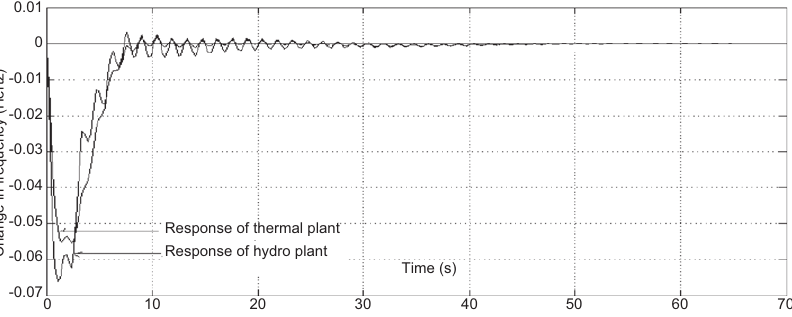
Figure 7. Change in Frequency (Hydro-Thermal Plant): With PI Controller.